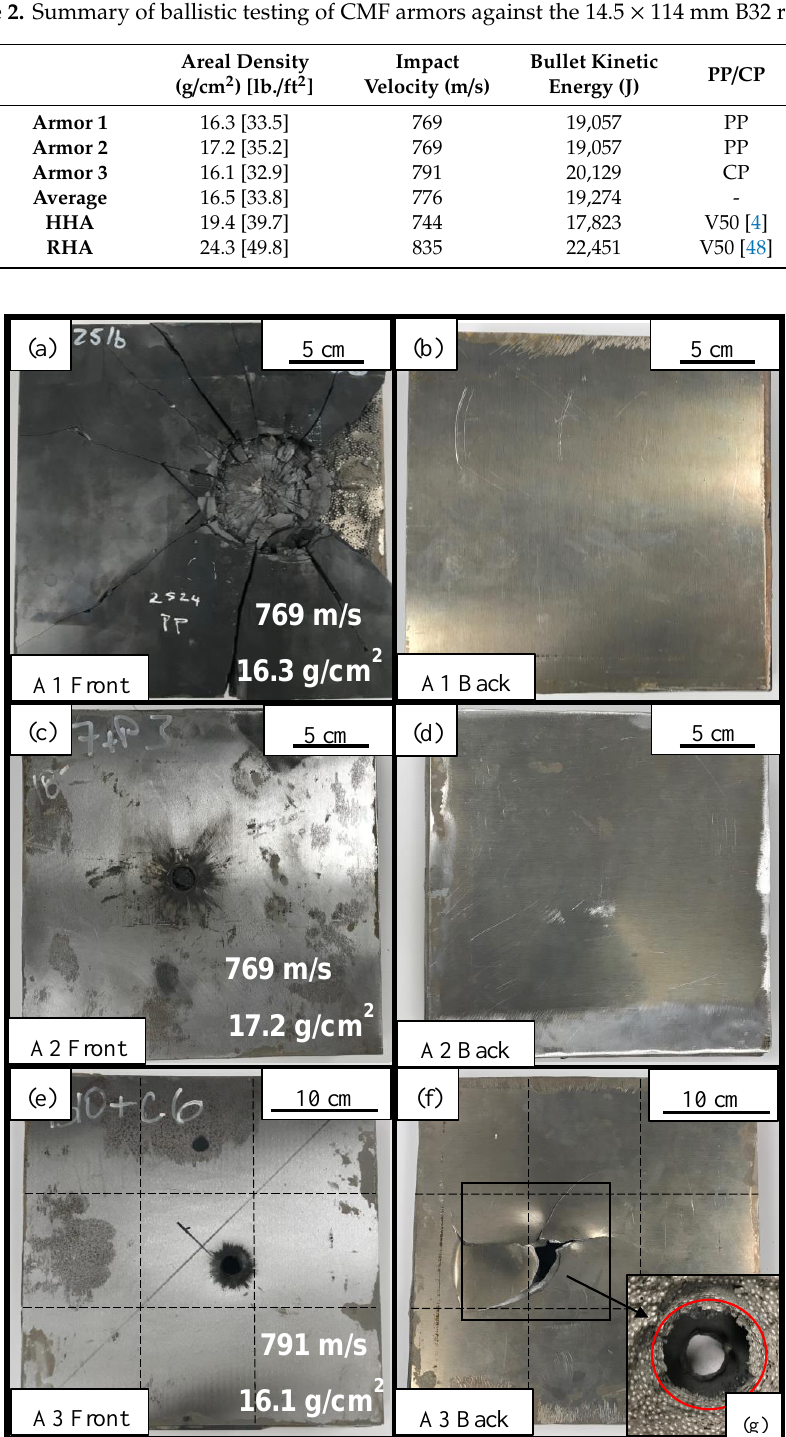
Figure 6. Digital images of the front ( a , c , e ) and back ( b , d , f ) of Armors 1, 2, and 3 following ballistic testing as well as additional images of the compressed spheres ( g ) in Armor 3. The CMF layer is exposed due to slight delamination of the aluminum backplate.